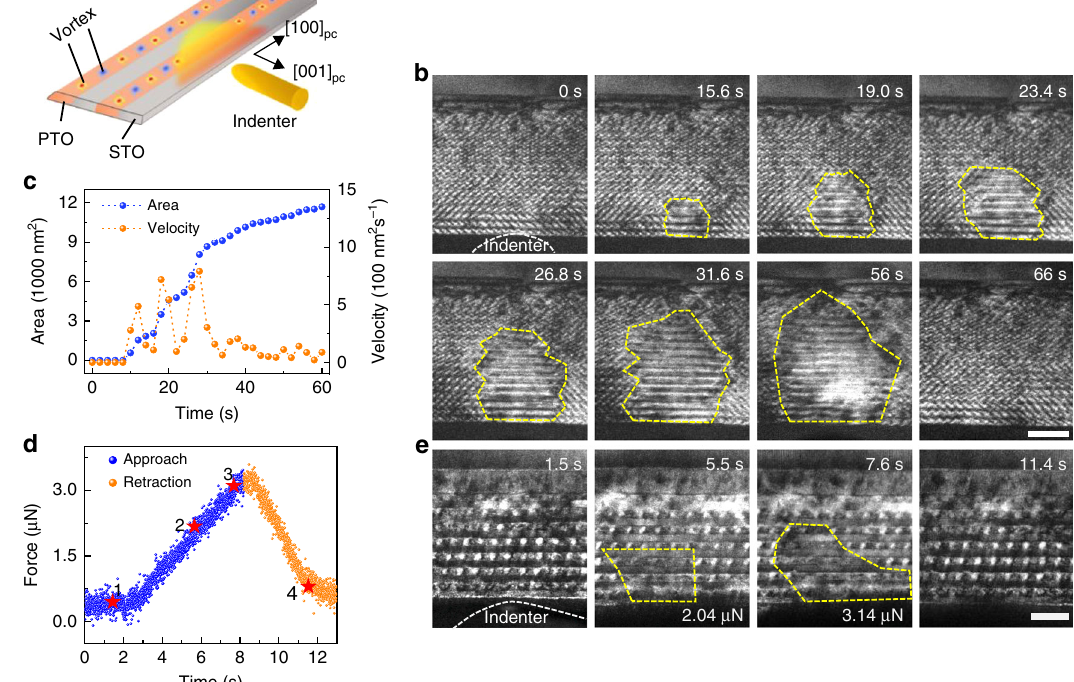
Fig. 2 Mechanical manipulation of vortices by in situ transmission electron microscopy (TEM). a Schematic image of the experimental setup, with a mobile tungsten tip acting as an indenter for the mechanical manipulation of vortices. b Chronological TEM dark- fi eld image series formed by re fl ection with ɡ = (200) pc . Under the mechanical loads, vortex contrast gradually disappears. Scale bar, 40 nm. c Corresponding transition area (blue line) and switching velocity (orange line) plotted as functions of time. d Mechanical loads as a function of time, with the blue points representing the approach branch and orange points corresponding to the retraction branch. The highlighted red stars along with labels 1 – 4 correspond to images in e . e Dark- fi eld images showing the vortex evolution under certain measured mechanical stress. Scale bar, 20